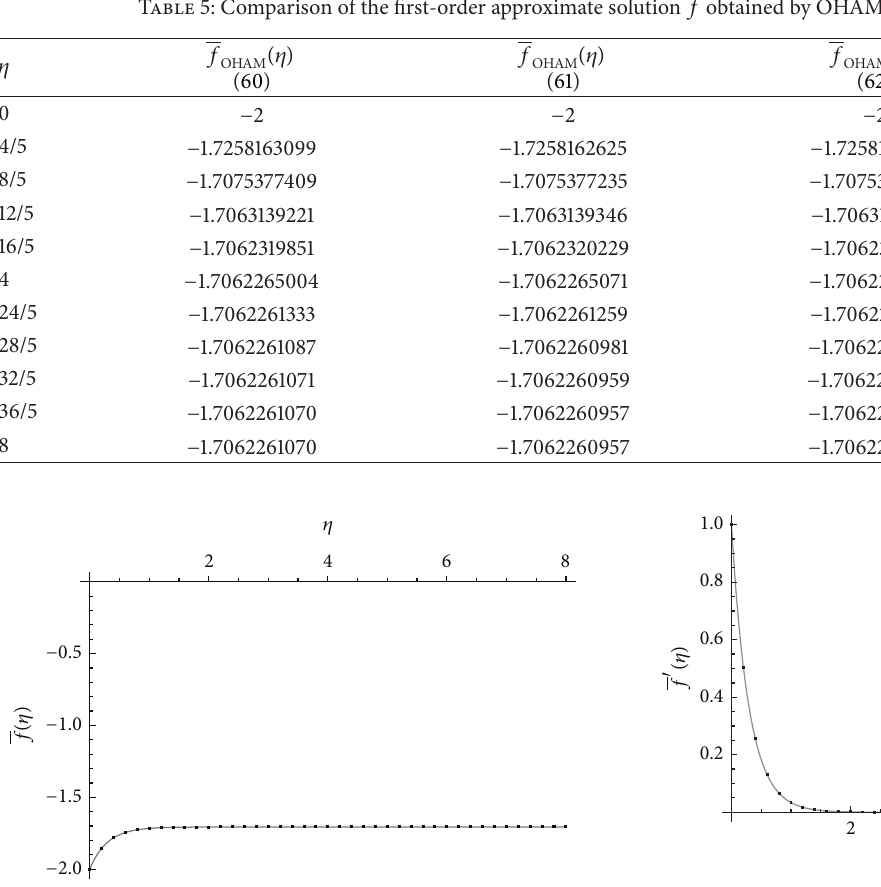
Figure 4: Comparison between the derivative of the first-order approximate solution of (60) and numerical solution in the follow- ing cases: 𝛽 = 0.5 , 𝑀 = 0.75 , and 𝑅 = −2 —numerical solution; ......... approximate